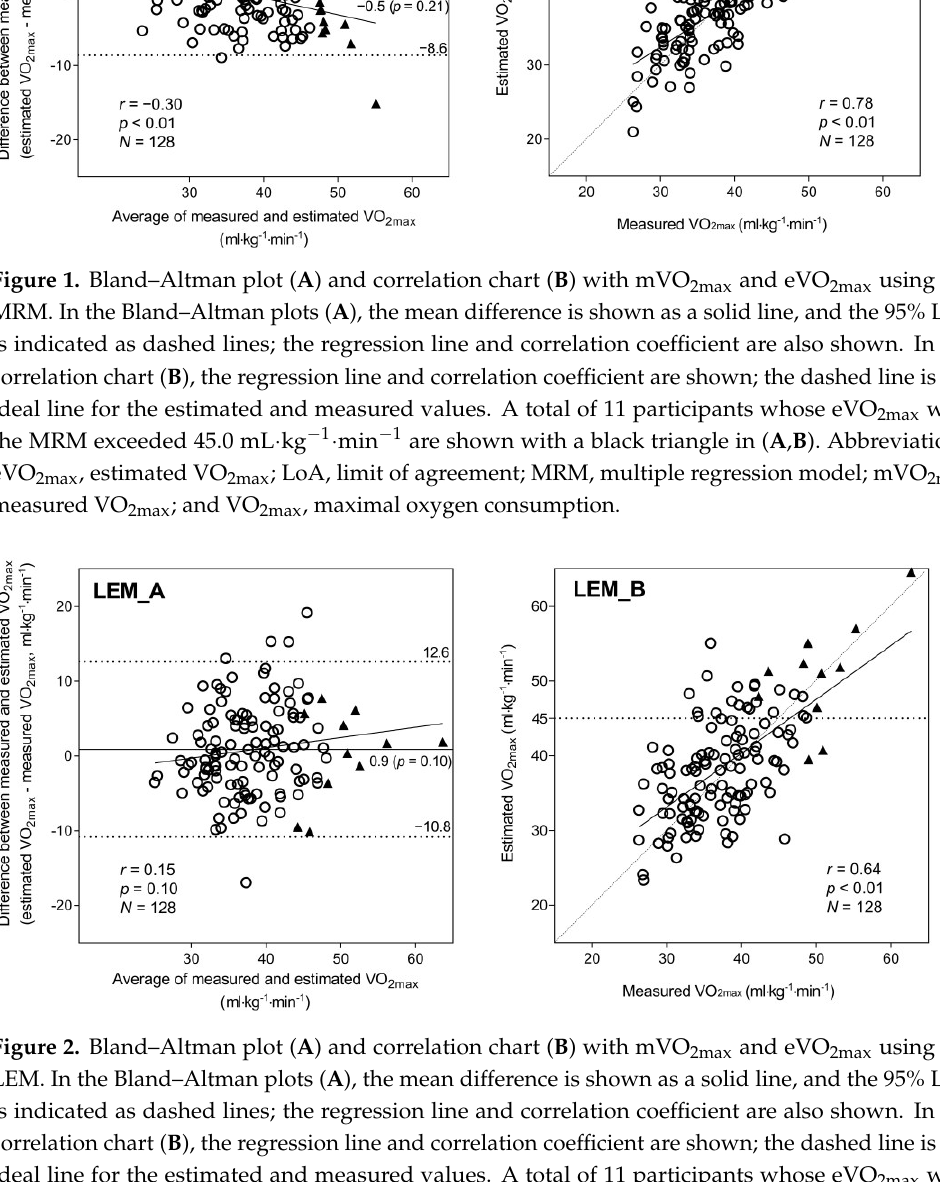
ideal line for the estimated and measured values. A total of 11 participants whose eV the MRM exceeded 45.0 mL · kg − 1 · min − 1 are shown with a black triangle in ( A , B ). Abbreviations: MRM exceeded 45.0 mL·kg −1 ·min −1 are shown with a black triangle in ( A ) and ( B ). Abbreviations: ． ． eVO 2max , estimated VO 2max ; LEM, linear extrapolation method; LoA, limit of agreement; MRM,